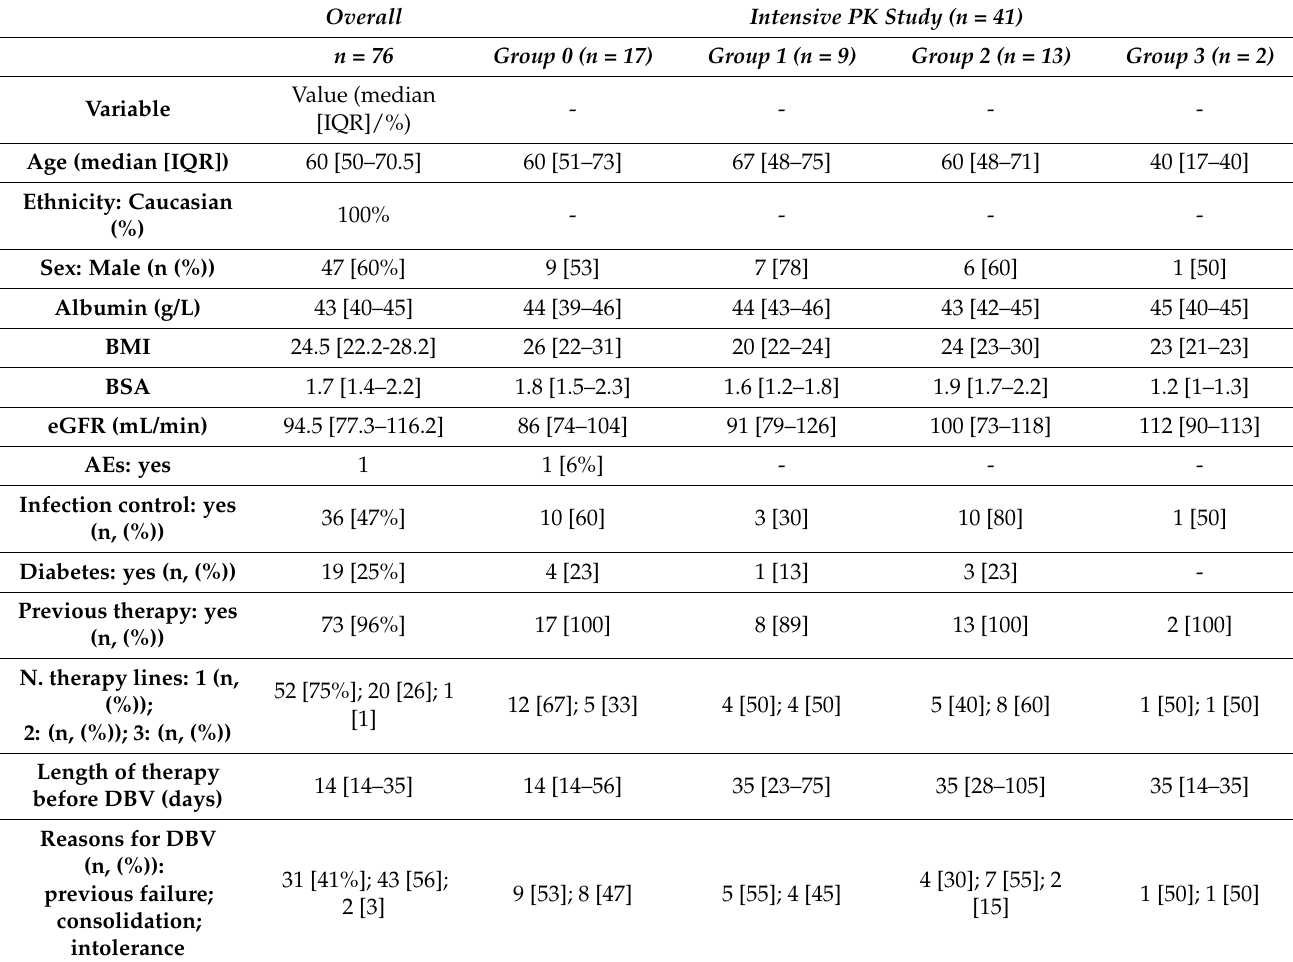
Table 1. Overall patients’ characteristics at the baseline.